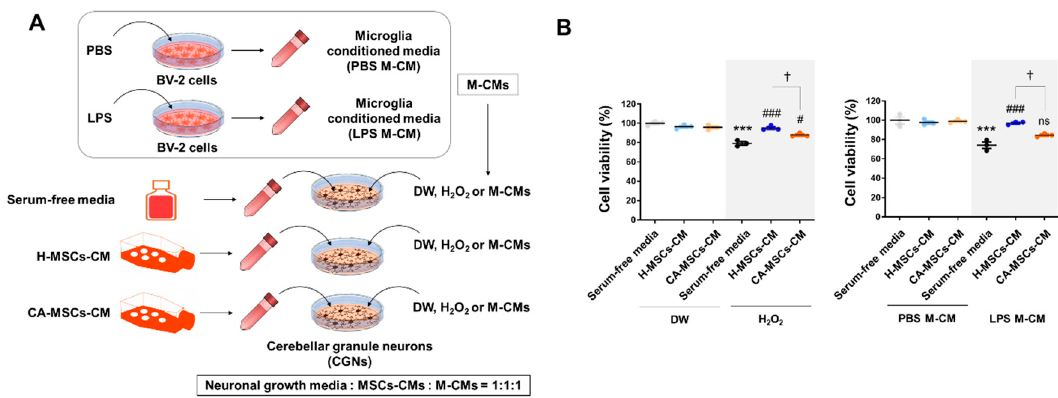
Figure 3. Characteristics of the neuroprotective potential of MSCs derived from CA-MSCs on oxidative stress or microglial toxicity. ( A ) Schematic drawing of the experimental procedure. The conditioned medium obtained from MSC culture was added with / without H 2 O 2 (200 µ M) or microglial conditioned medium (M-CM). M-CM was generated by BV-2 microglial cell culture stimulated with LPS (100 ng / mL) for 24 h. ( B ) Cell viability assay in cerebellar granule neurons (CGNs) was performed in triplicate. Cell viability was measured using the MTT assay. Results are presented as mean ± SEM obtained from MSC-CM from healthy subjects ( n = 3) or CA patients ( n = 3). One-way analysis of variance